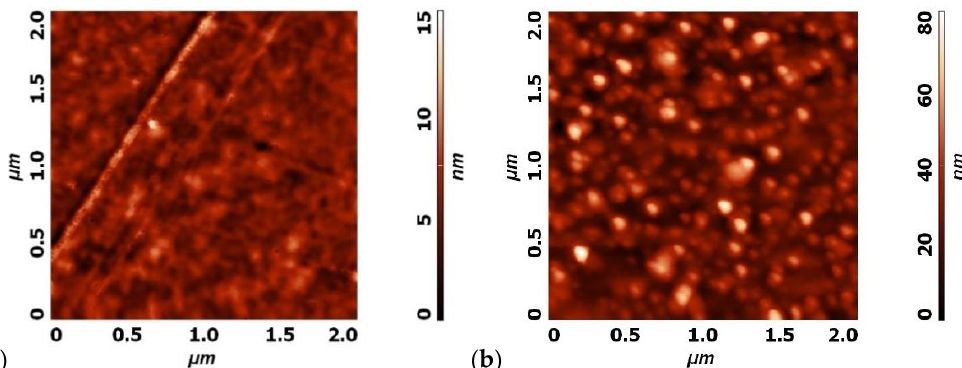
Figure 15. AFM images of: ( a ) The untreated PET foil and ( b ) the PET foil treated for 10 min at a distance of 5 mm.